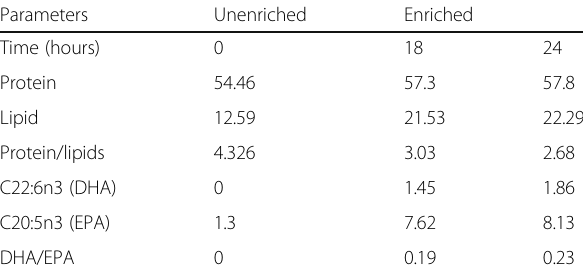
total protein or lipid concentration Fig. 3. A slight effect was noticed in the concentration of DHA and EPA fatty acids as illustrated in Fig. 4. On the other area, the length and stages were affected, for instance, 100% of nauplii achieved stage (1) after 18 h from incubation, while after 24 h 37% reached stage (2). The length also was changed from 574 ± 85 μ m after 18 h from enrich- ment to 646 ± 160 μ m after 24 h Fig. 5. The enrichment